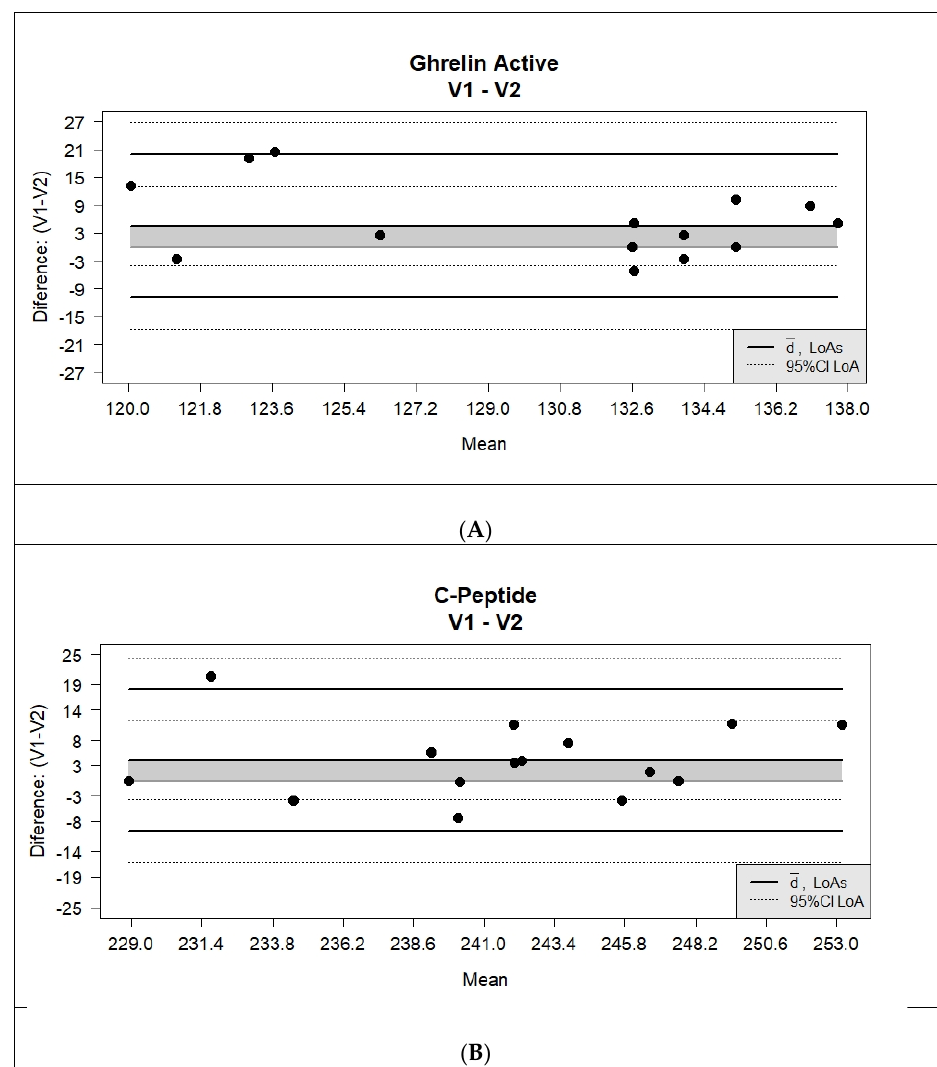
Figure 2. The Bland ‐ Altman plots for ( A ) active ghrelin and ( B ) C ‐ peptide. There were no correlations between tear fluid metabolic protein concentrations and (1) ocular surface parameters, including NITBUT and TER values ( p > 0.05); and (2) rela